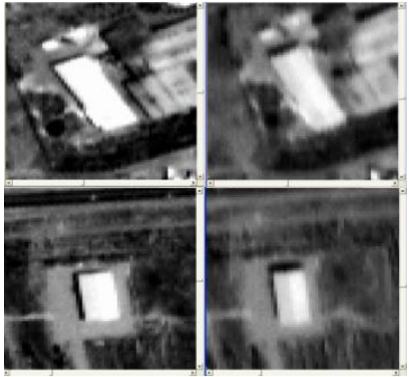
Figure 1. Two examples of radiometric blurring and scale distortion between two homologous